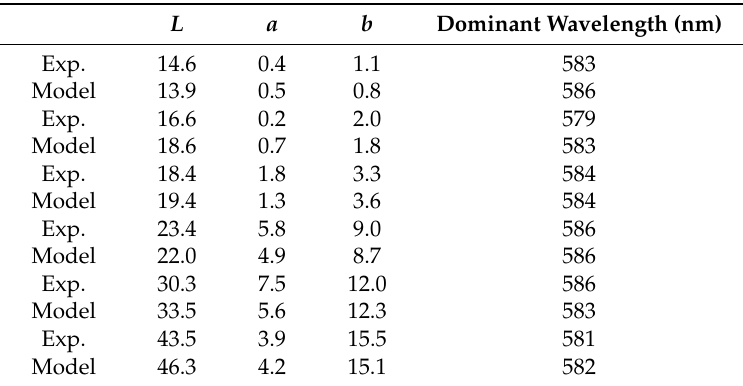
Table 2. Color Parameters of Hair.